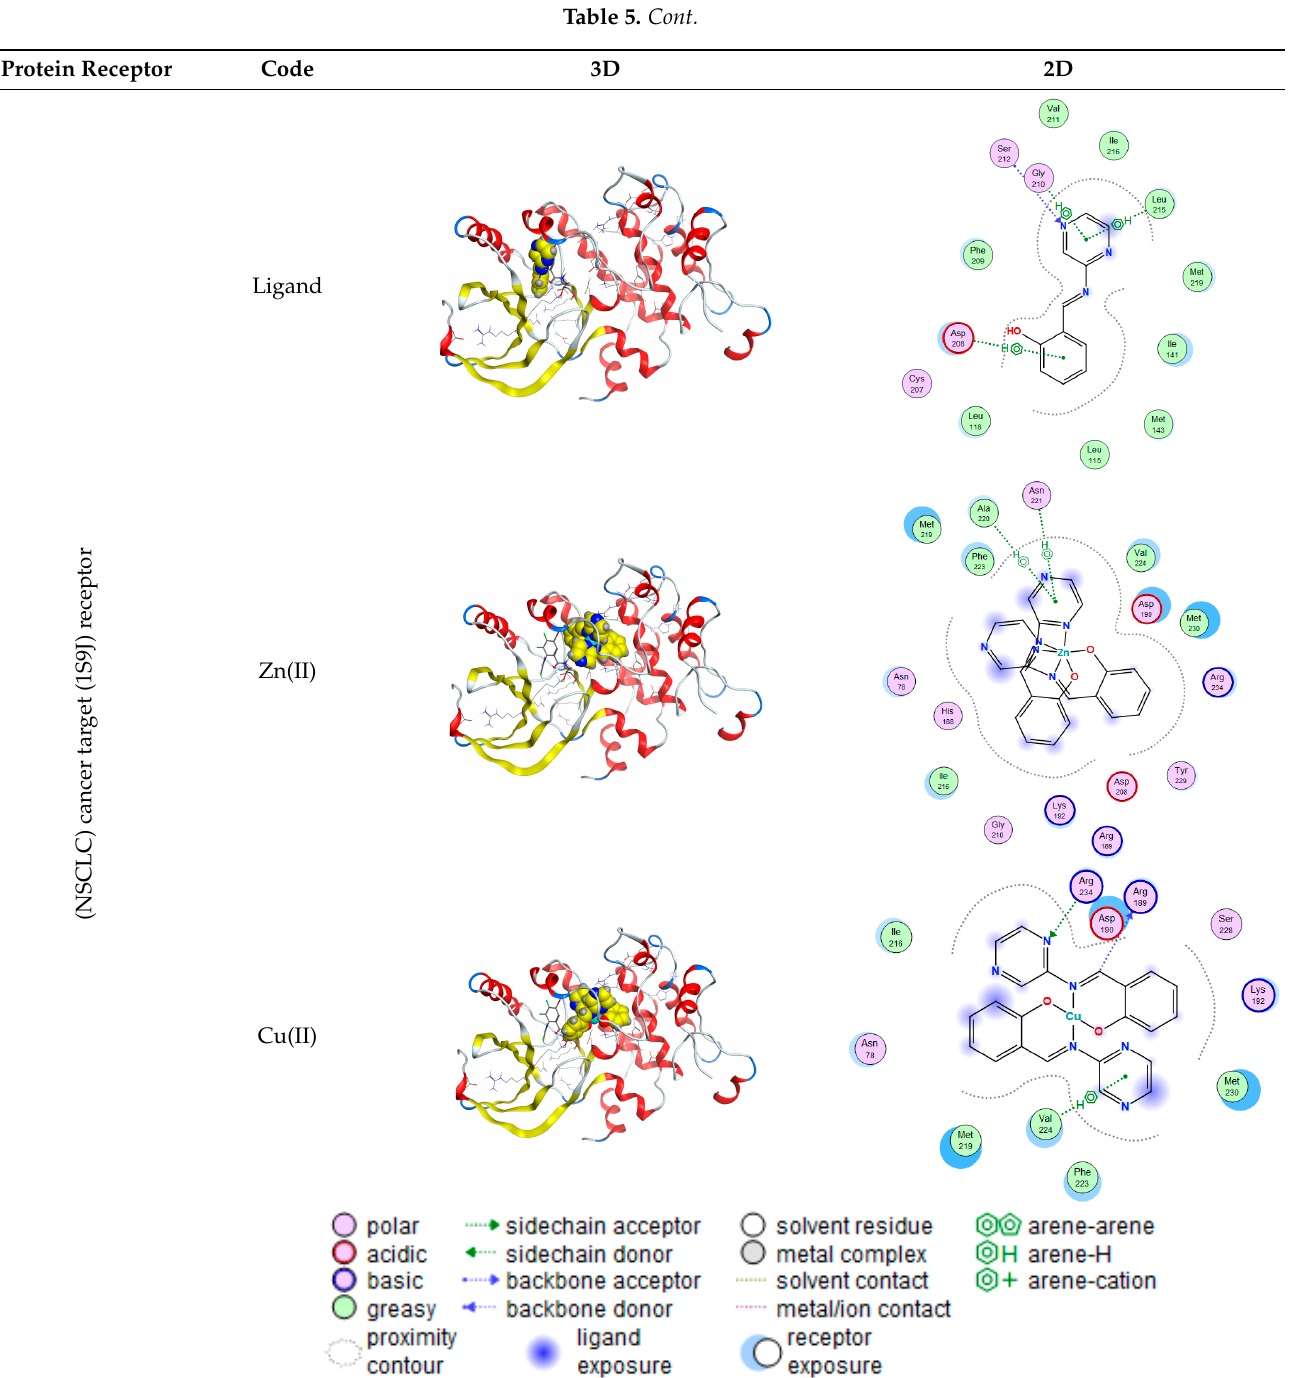
Table 6. In vitro anticancer activity of (Ovra3), (M14), and (HOP-62) cancer cell lines. Types of Cell Cancer Code